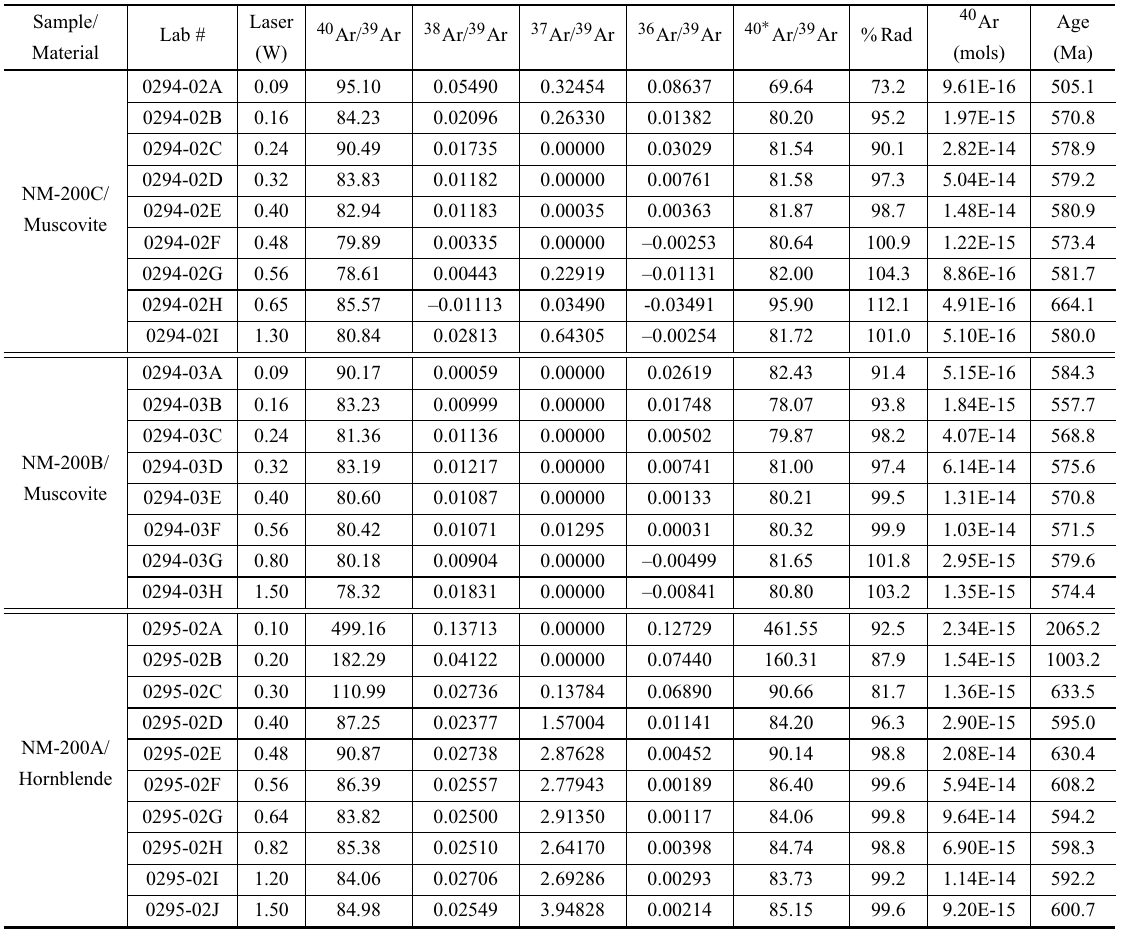
TABLE I 39 Ar/ 40 Ar analytical data obtained from muscovite (pegmatite) and hornblende (mylonitic orthogneiss) of the Costeiro Granite Belt in the Cajati